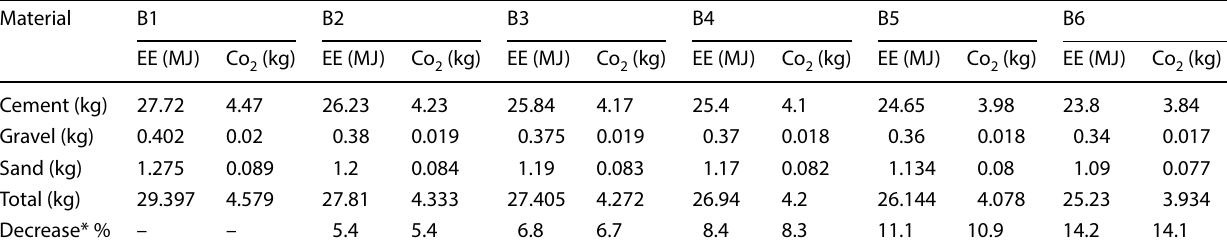
) emissions of the solid beam and hollow-core concrete 2